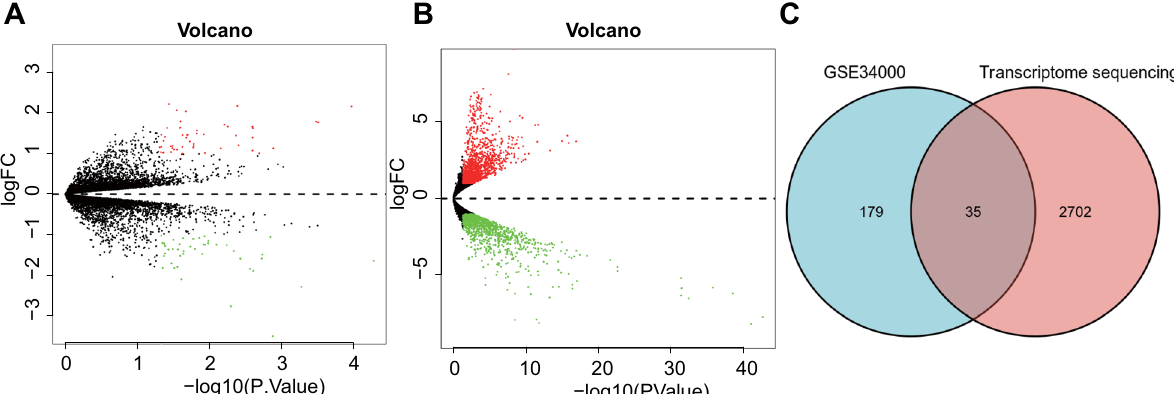
Fig. 2 Screening for key genes involved in the IDD of T1DM rats. A A volcano map of DEGs in microarray data GSE34000. Normal rats (n and STZ‑induced T1DM rats (n 3). Black dots represent genes without differential expression, red dots represent the upregulated genes, and = green dots represent downregulated genes). B A volcano map of DEGs in transcriptome sequencing. Normal rats (n IDD rats (n 3). Black dots represent genes without differential expression, red dots represent the upregulated genes, and green dots represent = downregulated genes). C Venn diagram of DEGs between transcriptome sequencing and microarray data